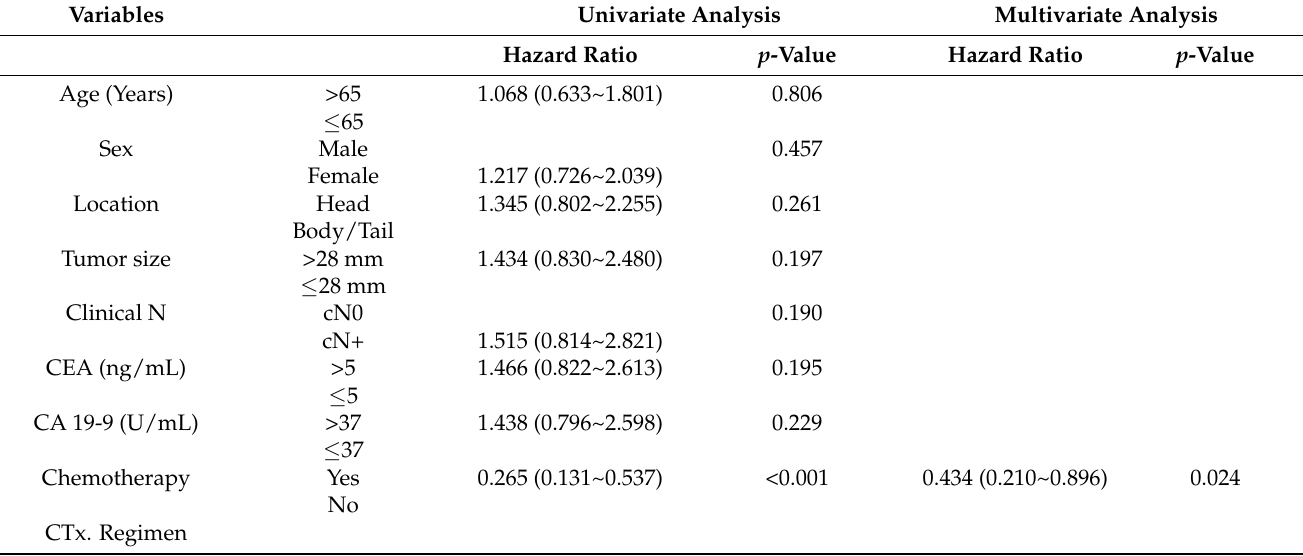
Table 2. Univariate and multivariate analysis regarding the factors influencing survival after the occurrence of metastasis.